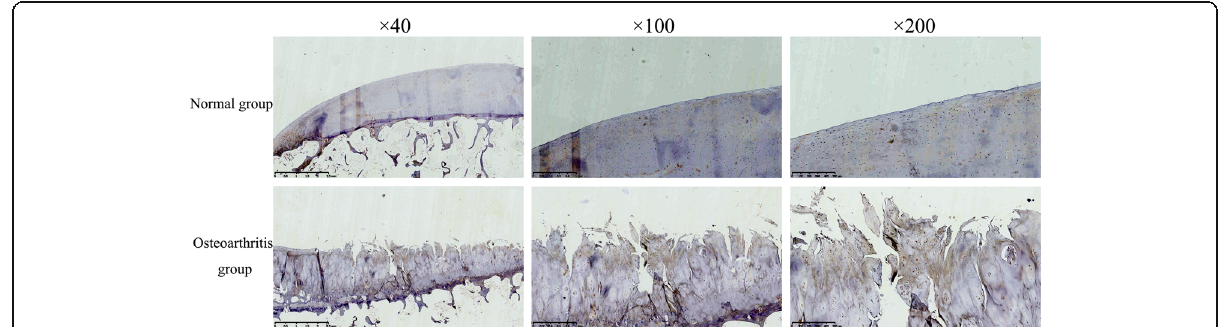
Fig. 4 The HIF-2 α staining of the cartilage in the normal group and osteoarthritis